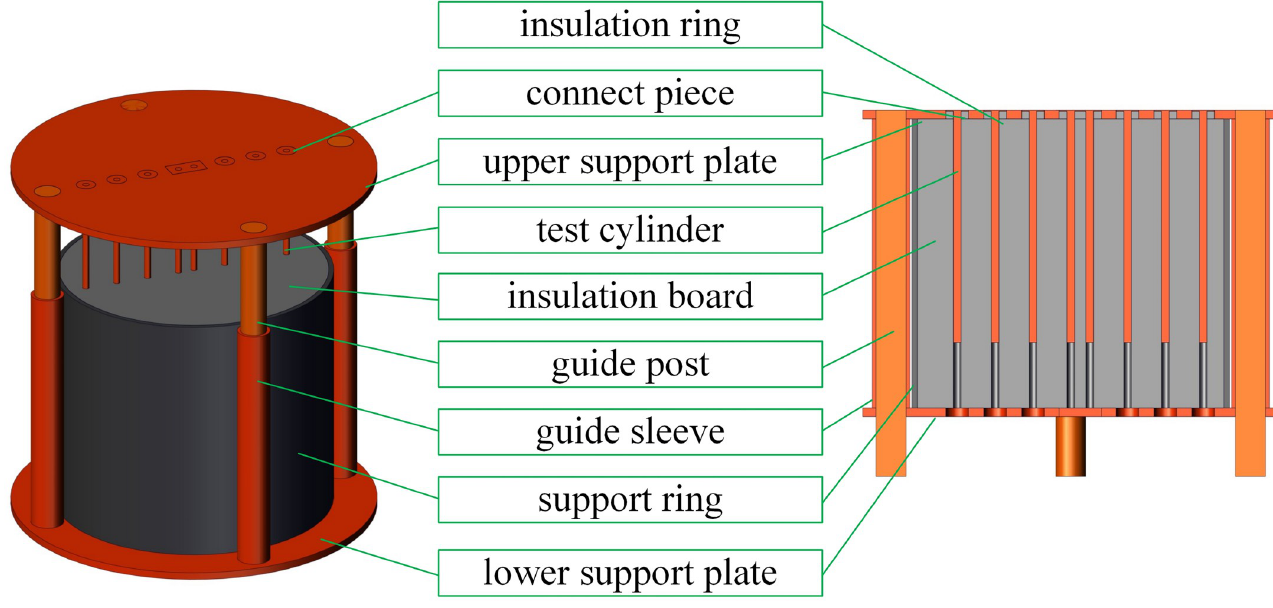
Fig 2. Detailed view of the device of the discrimination-experiment